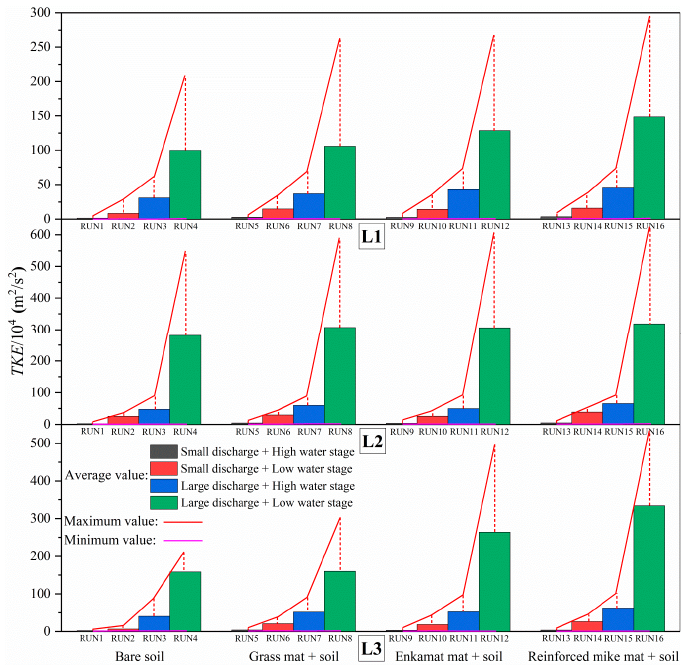
Figure 5. Distribution for turbulent kinetic energy on the vertical lines.